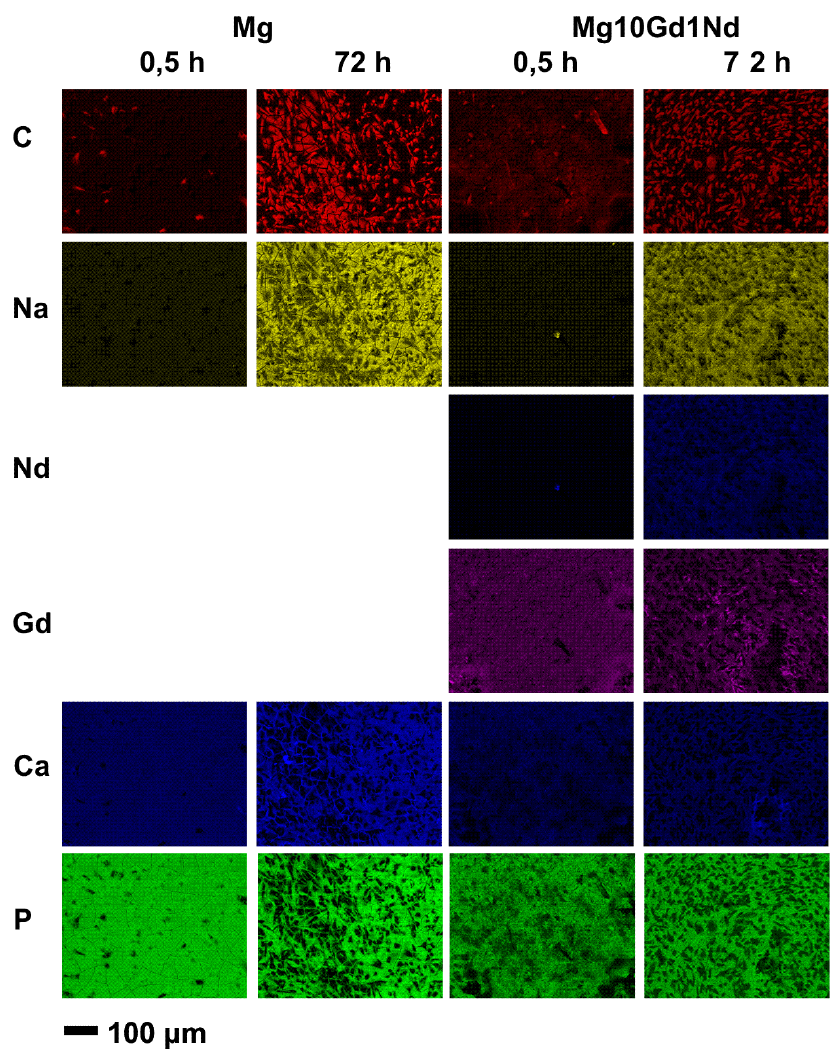
Figure 4. EDX element mapping of specimens with Saos-2 cells incubated on two materials with varying pre-incubation